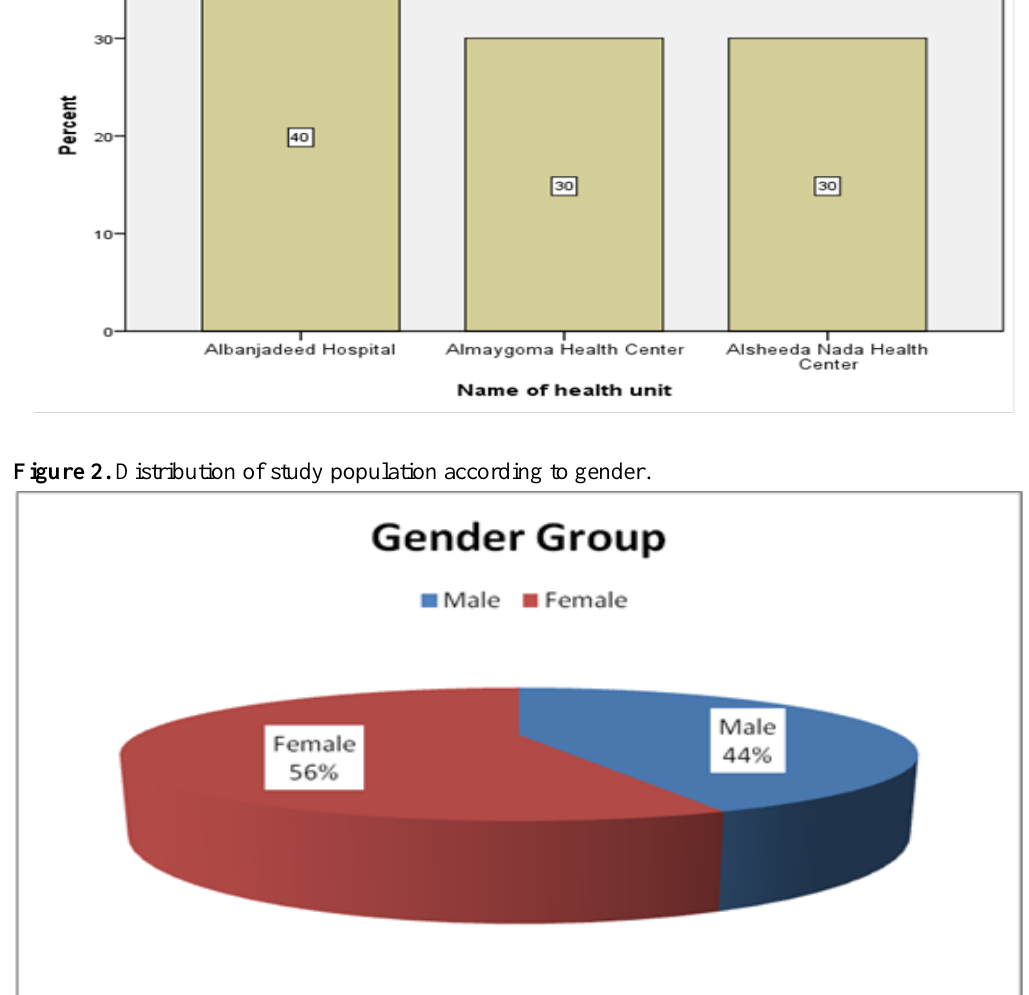
This figure showed that gender males represented 44% and females represented 56% among study population .